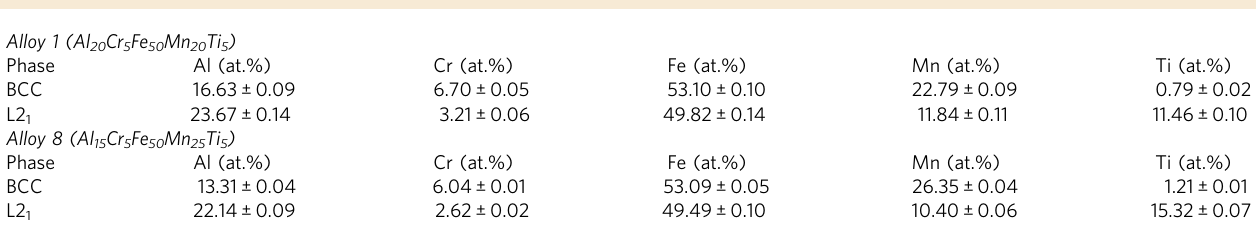
Fig. 3 Mechanical responses of the discovered LWHEAs. a Compressive stress-strain plots of Alloys 1 – 8 at RT. b Comparison of yield strengths as a function of temperature between Alloys 1, 8, and other counterpart materials (all these BCC-base alloys are in their as-cast states) 23 – 27 . c , d Lattice strain as a function of applied stress along the loading direction in Alloys 1 and 7 at RT, respectively, measured by in situ neutron diffraction. The error bars are obtained from the uncertainties of the single-peak fi tting on hkl diffraction peaks. Table 1 Chemical compositions of the BCC and L2 1 phases in Alloys 1 and 8, measured by